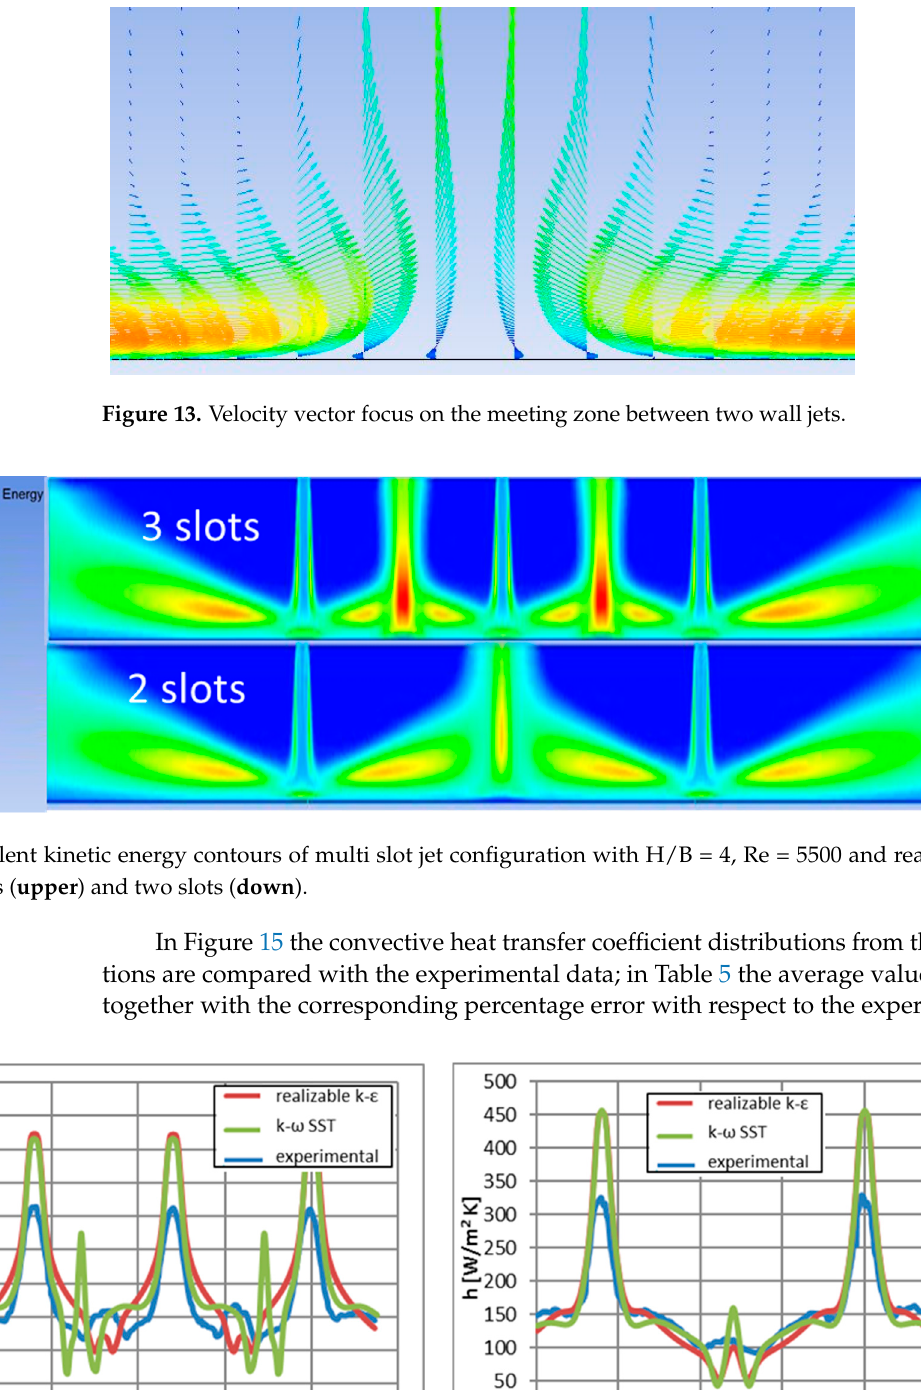
k- ε model: three slots ( upper ) and two slots ( down ).